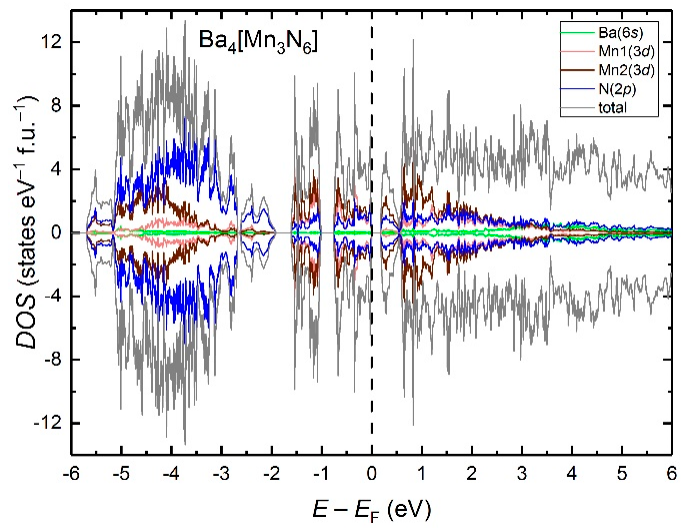
Figure 6. LSDA electronic density of states for Ba 4 [Mn 3 N 6 ] in the AFM1 structure. Positive and negative DOS values correspond to major and minor spin channels, respectively.